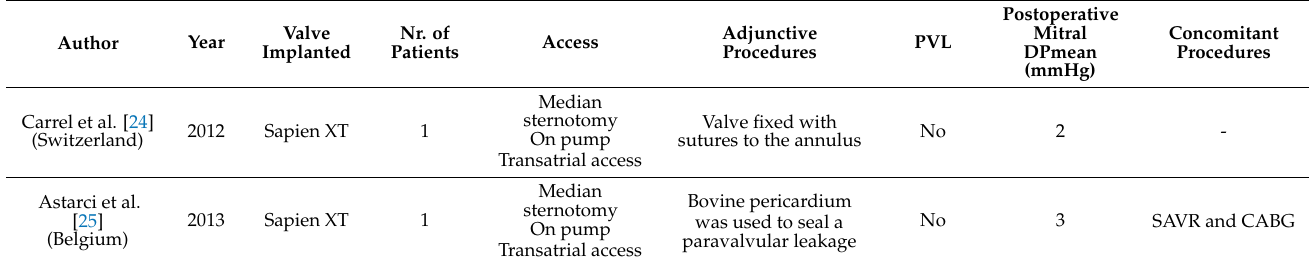
Table 3. Review of literature of hybrid approaches to transcatheter mitral valve replacement in the setting of mitral annular calcification. CABG: Coronary Artery Bypass Grafting, LAAE Left Atrial Appendage Excision, SAVR: Surgical Aortic Valve Replacement, TAVR: Transcatheter Aortic Valve Replacement, TVr: Tricuspid Valve repair.